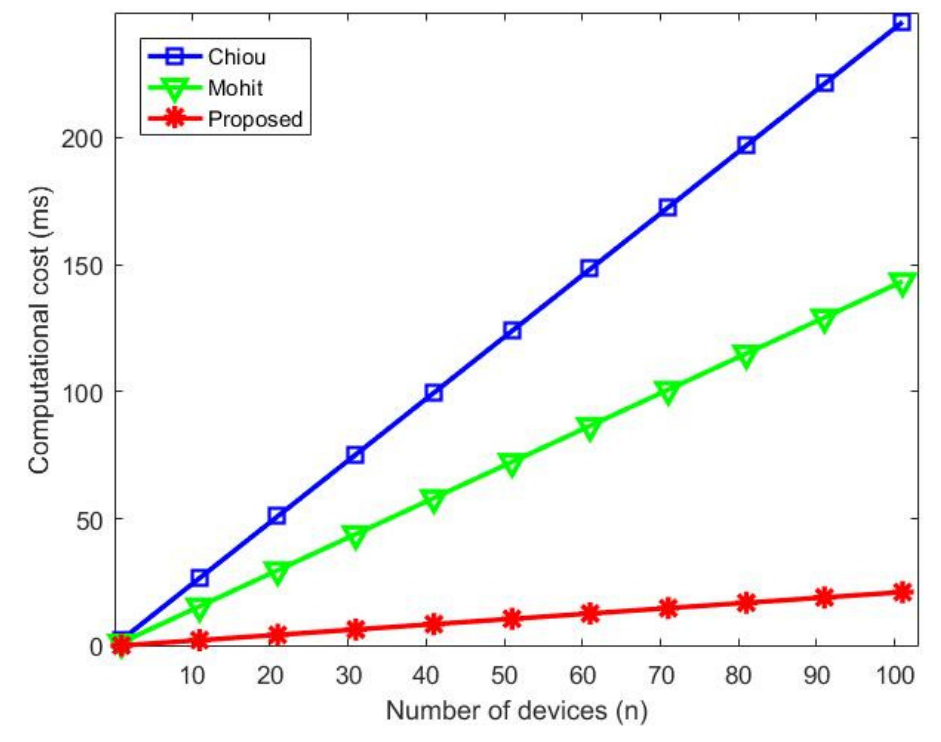
Figure 7. Computational cost comparison.